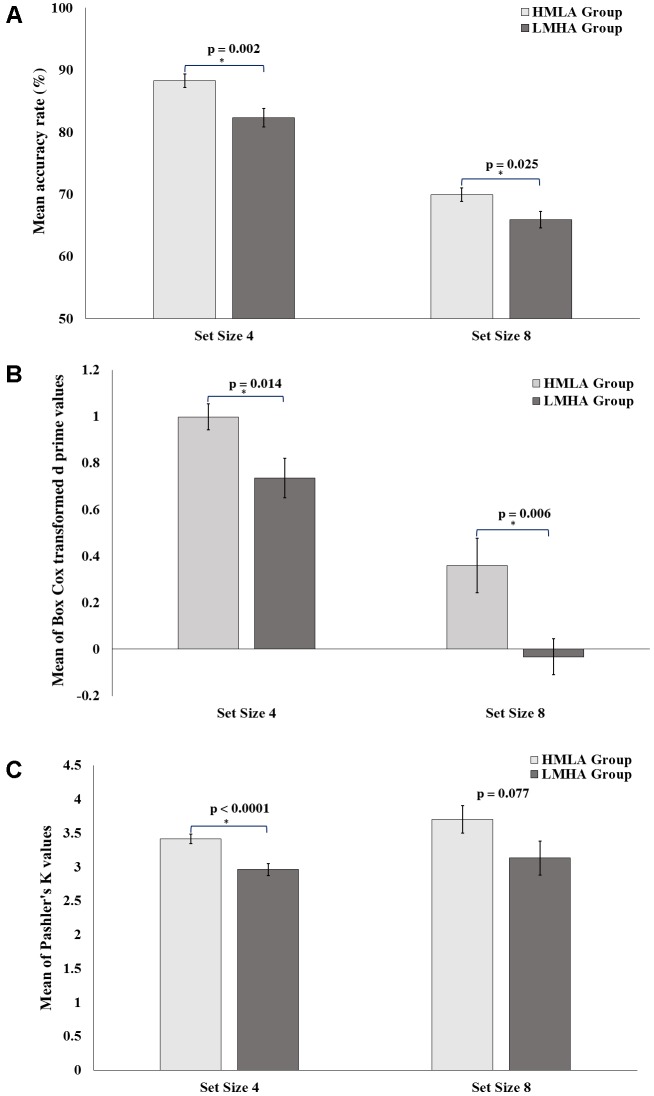
Results from the VWM change detection task and comparison in performance between the HMLA and LMHA groups. (A) Mean accuracy rate (%) for set size 4 and set size 8. (B) Mean of Box Cox power transformed d prime values for set size 4 and set size 8. (C) Mean of Kp for set size 4 and set size 8. Error bars represent standard errors of the mean. ∗p-Values reported here are after Holm–Bonferroni corrections.